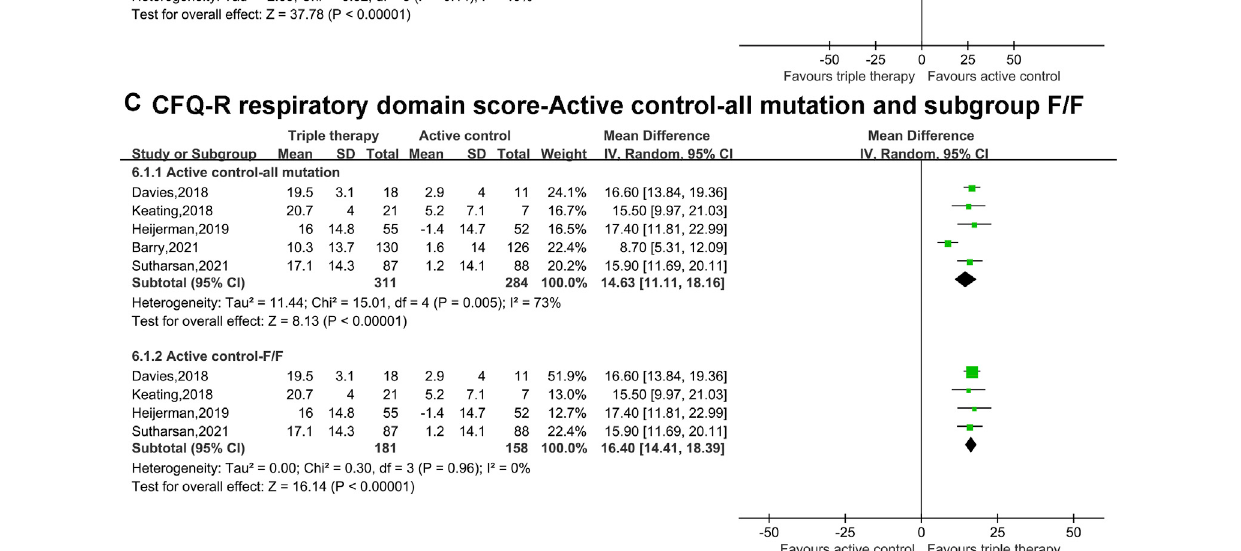
FIGURE3| Forestplotsoftheincludedstudiesevaluatingtheef fi cacyoftriplecombinationtherapyvs.activecontrolwithallmutationsandsubgroup analysisofF/ F mutations. (A) ppFEV 1 . (B) Sweat chloride concentration. (C) CFQ-R respiratory domain score.